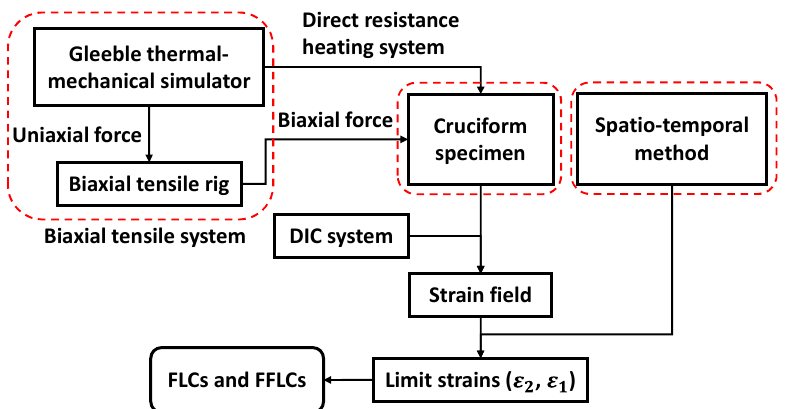
Figure 5. A recent novel biaxial test method for formability evaluation under hot-stamping conditions, comprising a biaxial tensile system to stretch cruciform specimens in different strain states until fracture, along with the measurement of strain fields using the DIC, and a spatio-temporal method to determine the necking and fracture limit strains [7].